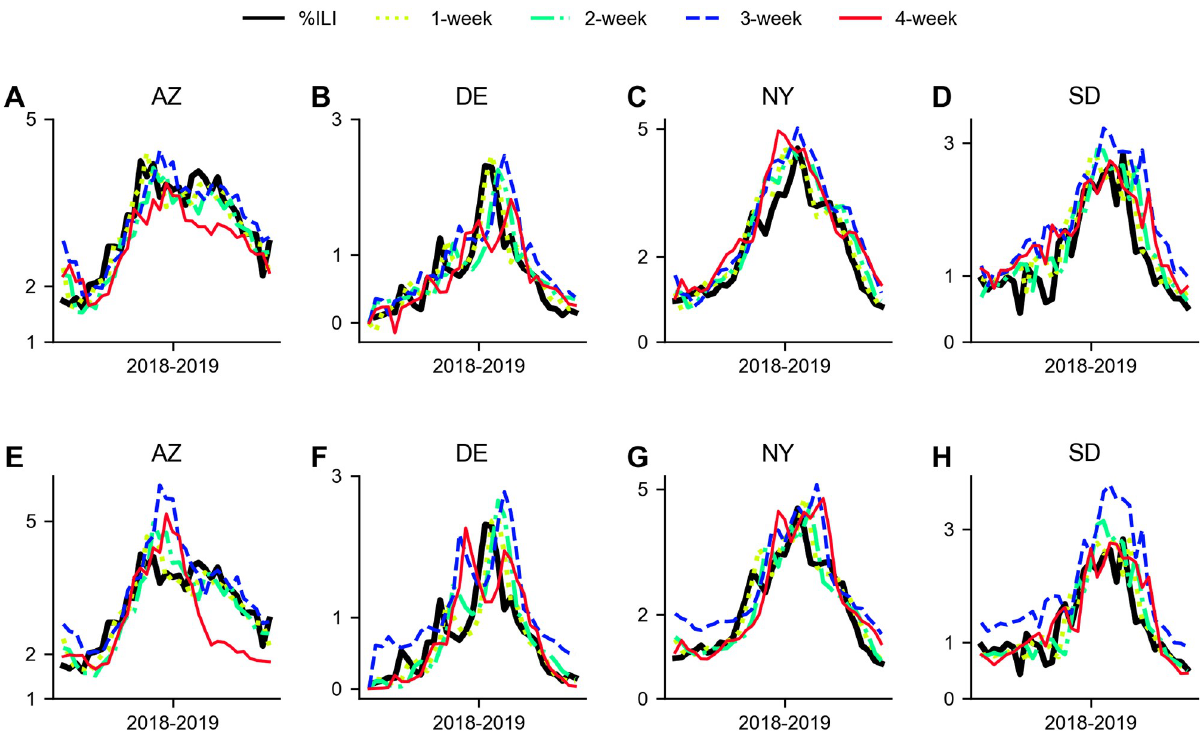
Fig 16. Example plots of %ILI in 4 states {AZ, DE, NY, SD} and predictions made by SNAIL and Seq2Seq for 2018–2019 (test). A. Arizona— SNAIL, B. Delaware—SNAIL, C. New York—SNAIL, D. South Dakota—SNAIL, E. Arizona—Seq2Seq, F. Delaware—Seq2Seq, G. New York—Seq2Seq, H. South Dakota—Seq2Seq. The original %ILI is depicted in solid black lines and the {1, 2, 3, 4}-weeks ahead prediction results are depicted in dotted yellow-green lines, dash-dot light green lines, dashed blue lines, and solid red lines, respectively.